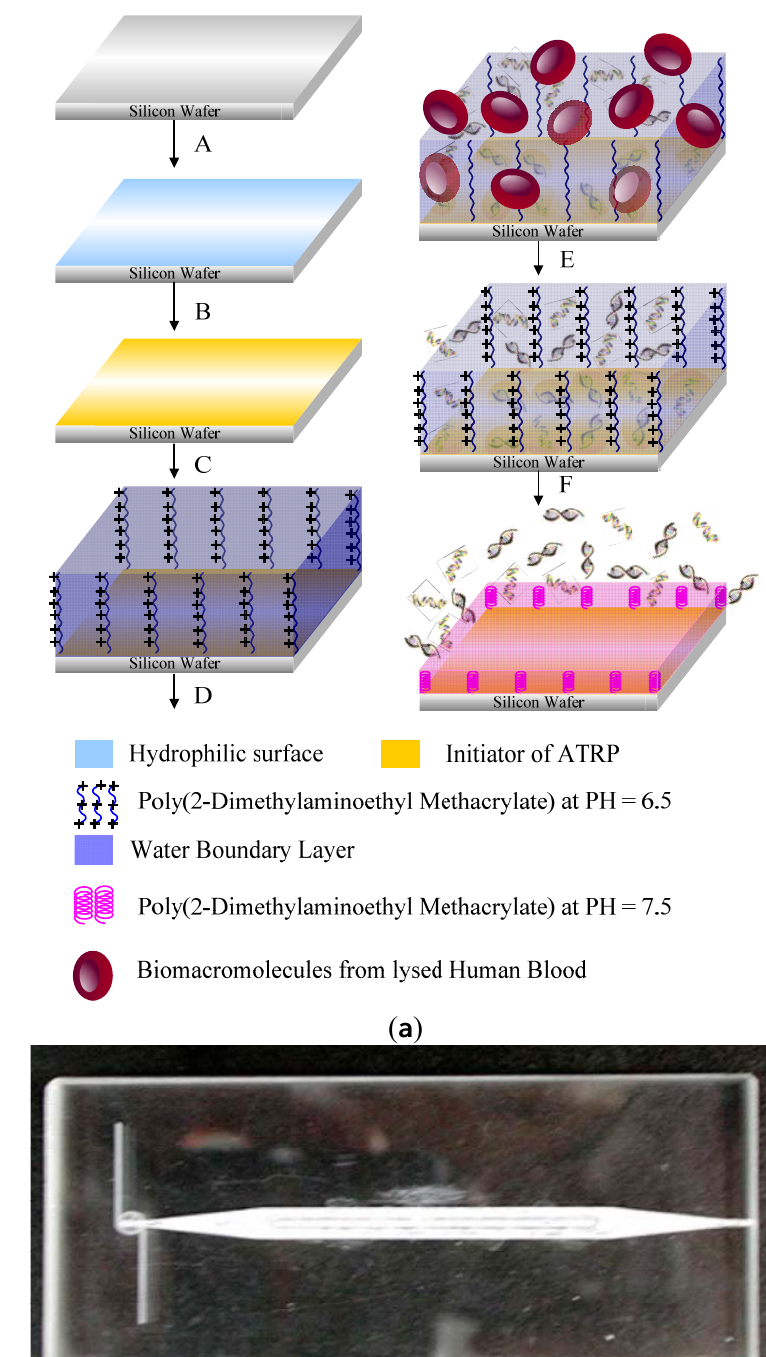
Figure 15. ( a ) Schematic representation of the capture and release of specific gDNA from a specimen of lysed human blood cells by tethered Poly[2-(dimethylamino)-ethyl methacrylate] (PDMAEMA) on an Si surface [200]; ( b ) Optical microscope image of the fluidic system with the straight channels. Reprinted from Reference [178] with